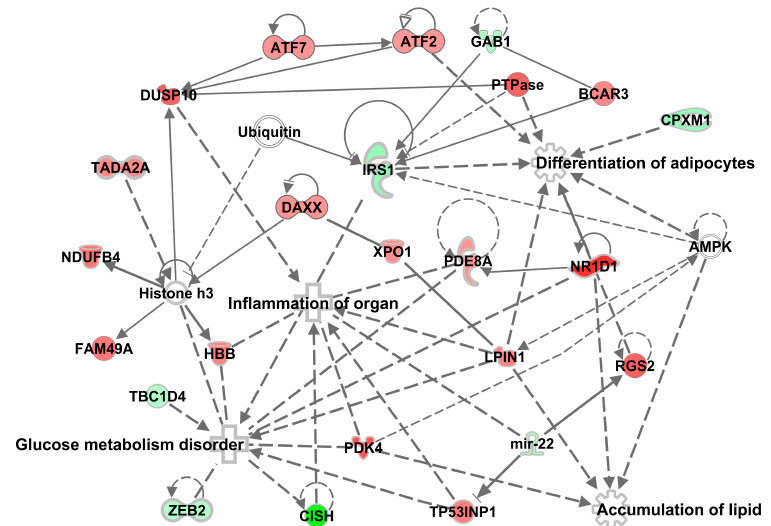
Figure 3. Mechanistic network showing the highest score for a set of significantly differentially expressed genes in MG (methylglyoxal)-treated rats. The level of change in expression is highlighted in shades of green (MG downregulation) and red (MG upregulation). Network derivation was performed using Ingenuity Pathway Analysis software.